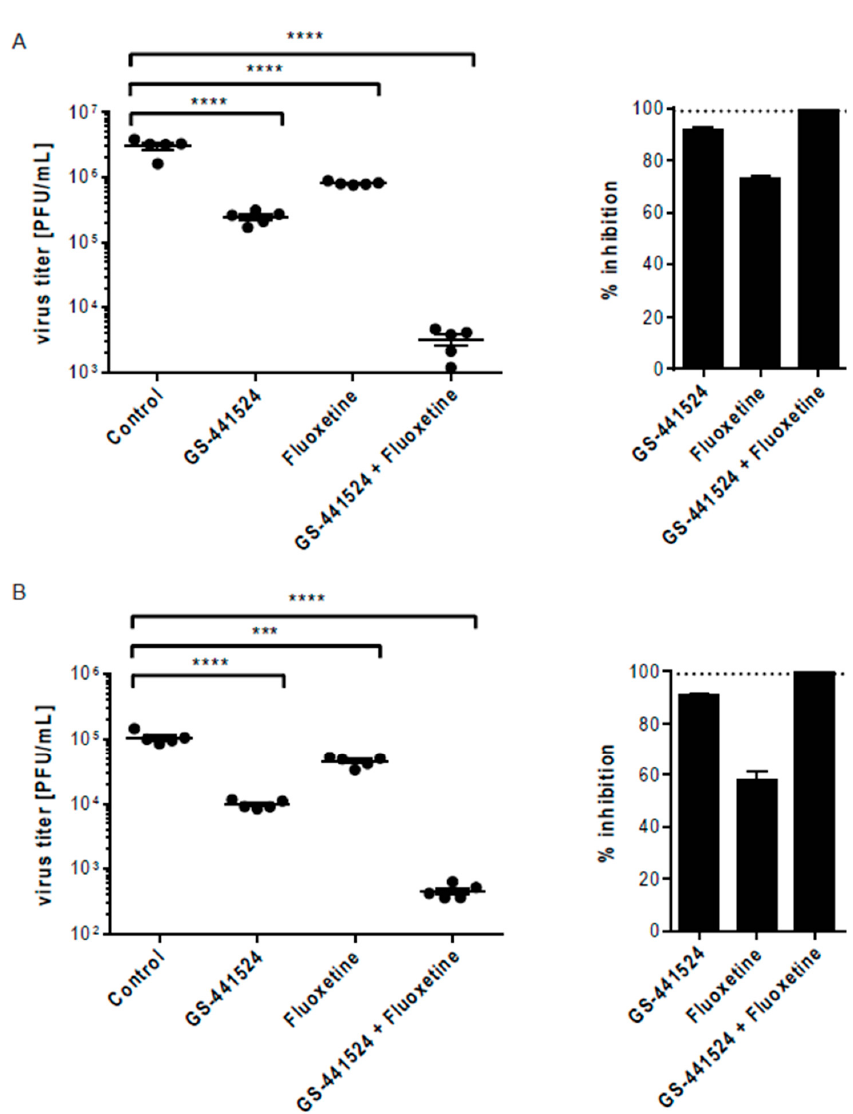
Figure 5. Antiviral effect of the combination therapy with GS-441524 and fluoxetine against two newly emerged SARS-CoV-2 variants. Polarized Calu-3 cells were infected with the ( A ) alpha or ( B ) beta variant of SARS-CoV-2 and treated with 2.5 μ M fluoxetine, 1 μ M GS-441524 or the combination of both drugs for 48 h. ( A ) Data were expressed as plaque-forming units (PFU) per mL detected in a single experimental sample, lines indicate means; n = 5/treatment or as ( B ) percent pharmacological inhibition of infectious virus production for the drug pair fluoxetine and GS-441524 (with mean virus titer produced in control cells (treated with the solvent DMSO) set to 100%, n = 5. Dotted line, 99% reduction in viral titer. One-way ANOVA followed by Dunnett’s multiple comparison test. *** p ≤ 0.001, **** p ≤ 0.0001.